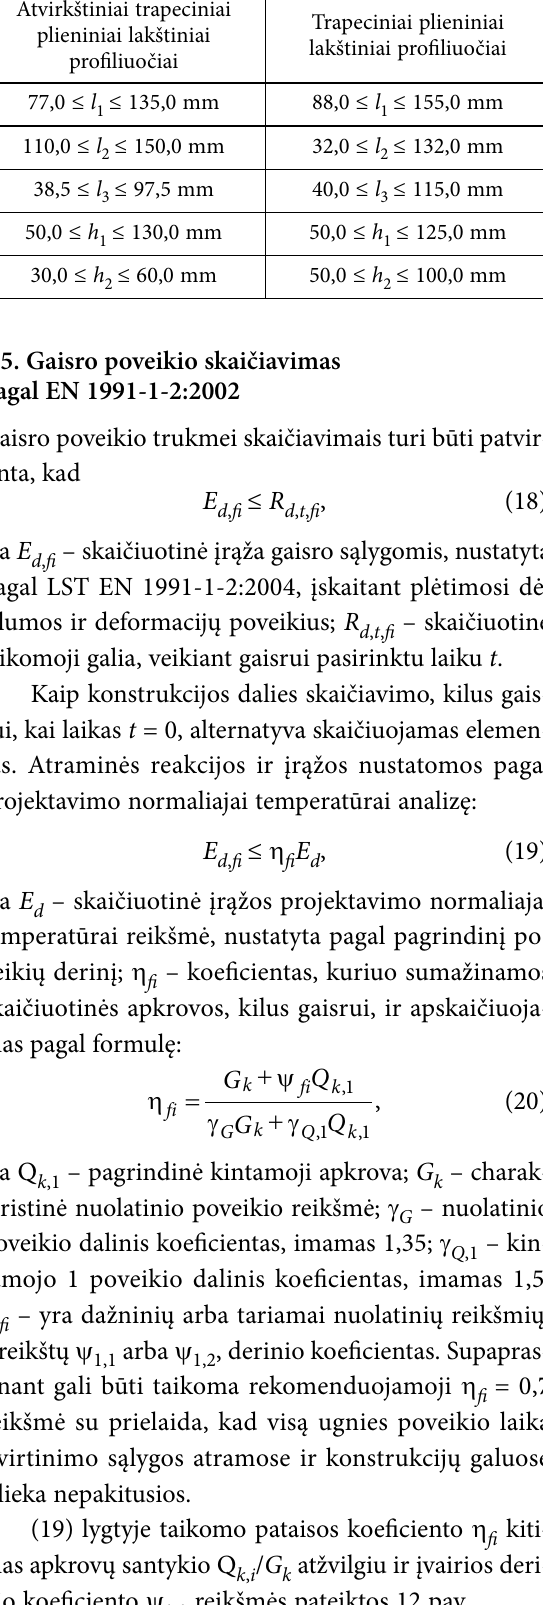
Table 7. Application zone